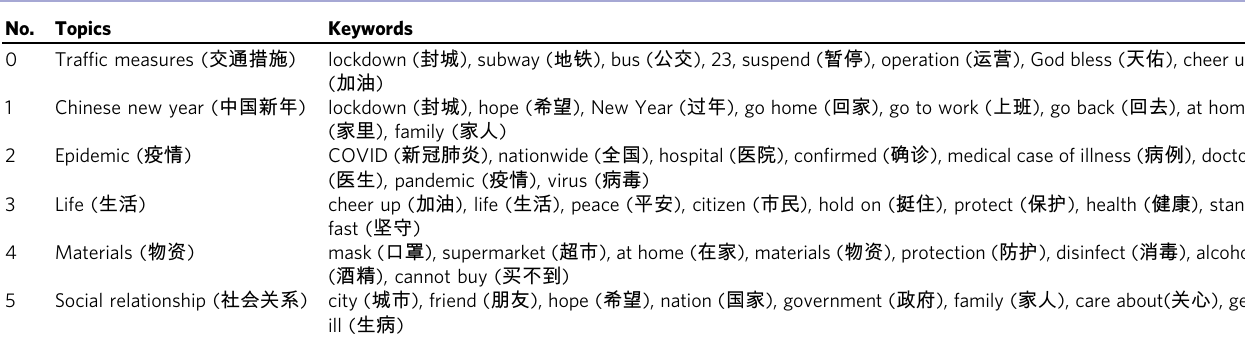
Table 2 Topics-keywords distribution on January 23 in Wuhan. No.